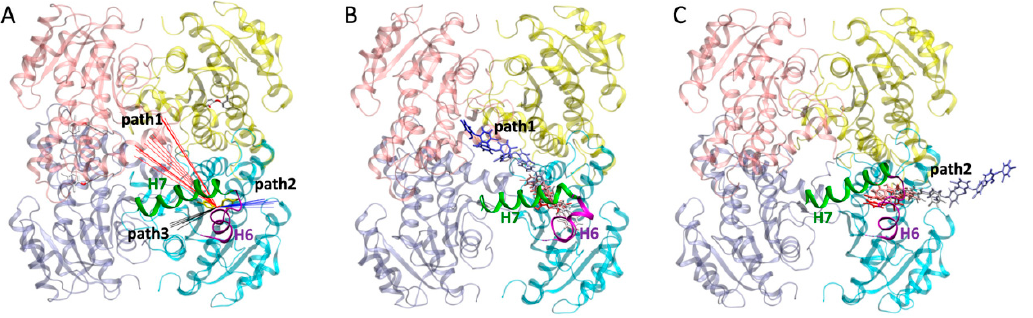
Figure 5. ( A ) Schematic diagram of three possible dissociation pathways (path1 to path3). ( B ) Sche- matic diagram of the dissociation path of TCL along path1. ( C ) Schematic diagram of the dissocia- tion path of TCL along path2.